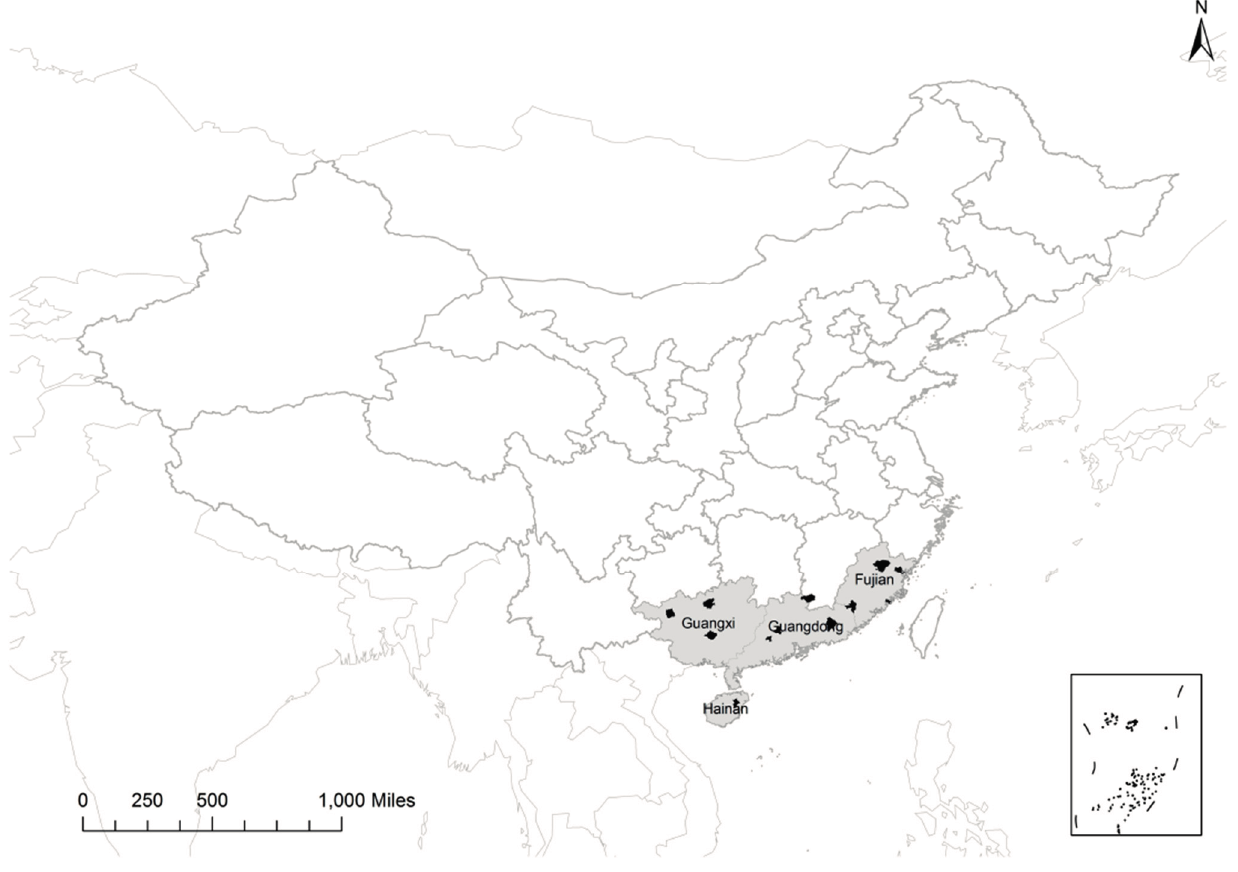
Figure 1. Distribution map of selected mortality surveillance sites in Southern